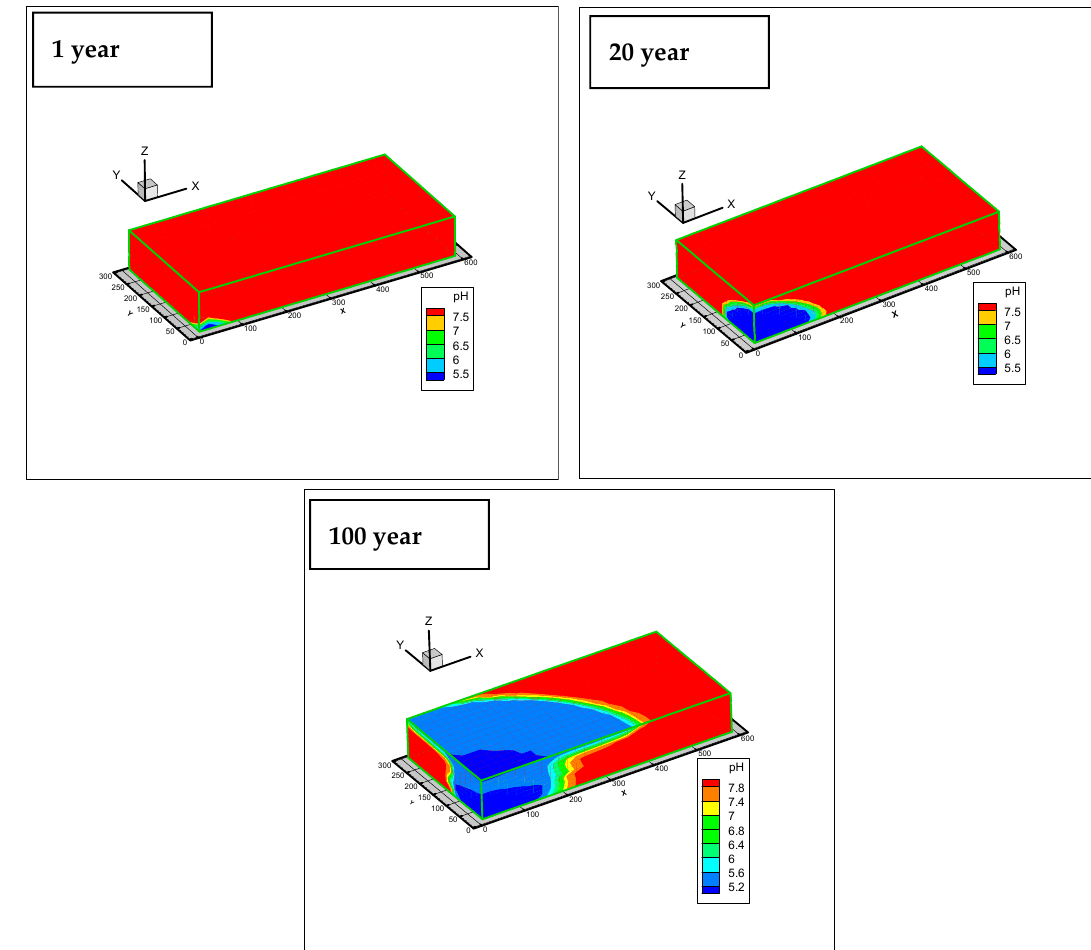
Figure 17. Contour maps of solution pH at subsequent durations of CO 2 leakage (one year of leakage; 20 years of leakage 100 years of leakage).